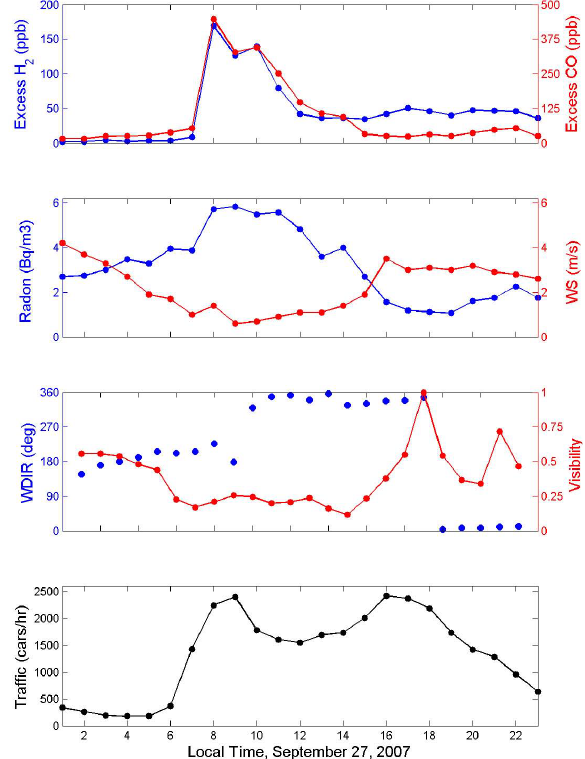
Fig. 9. Excess hydrogen and carbon monoxide mixing ratios, radon activity and weather parameters (wind speed, wind direction, visi- bility) at Kumpula, site and traffic flow at nearby H¨ameentie bridge in 27 September, 2007. Visibility is expressed as fraction of the maximum of the observation range, which is about 50km. Traffic data provided by Helsinki city traffic